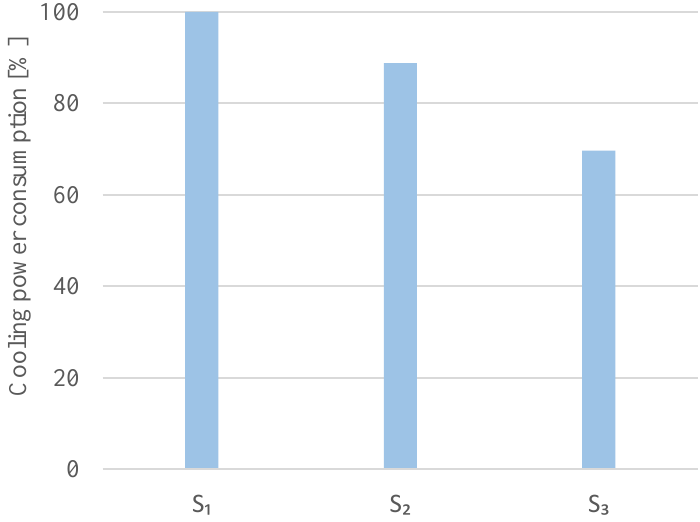
Figure 19. Comparison of normalized cooling power consumption between S 1 , S 2 and S 3